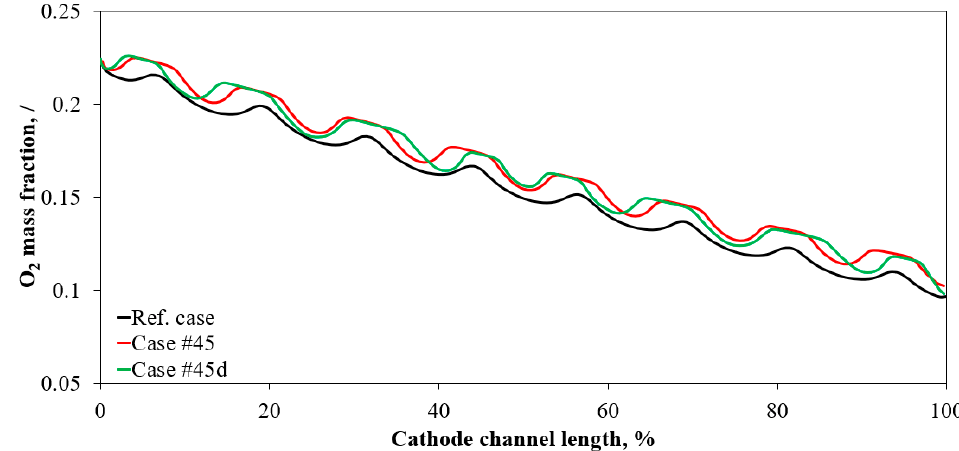
Figure 17. O 2 mass fraction along the substrate mid-line at operating current density of 4.0 A · cm − 2 for Ref. case and optimized geometries.